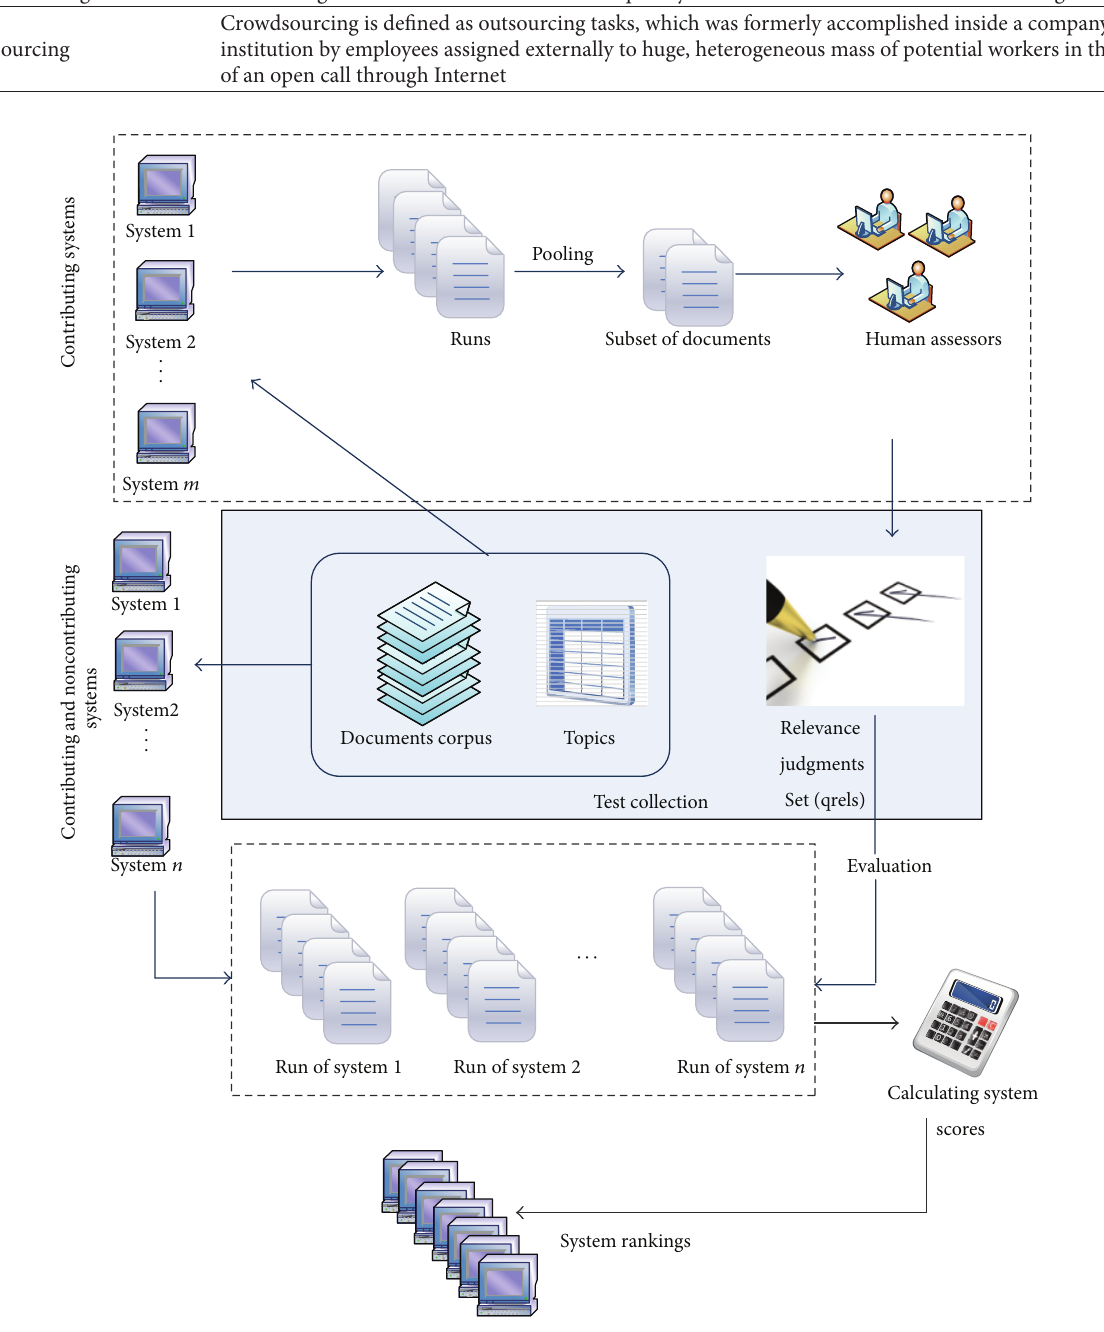
Figure 2: Typical IR evaluation